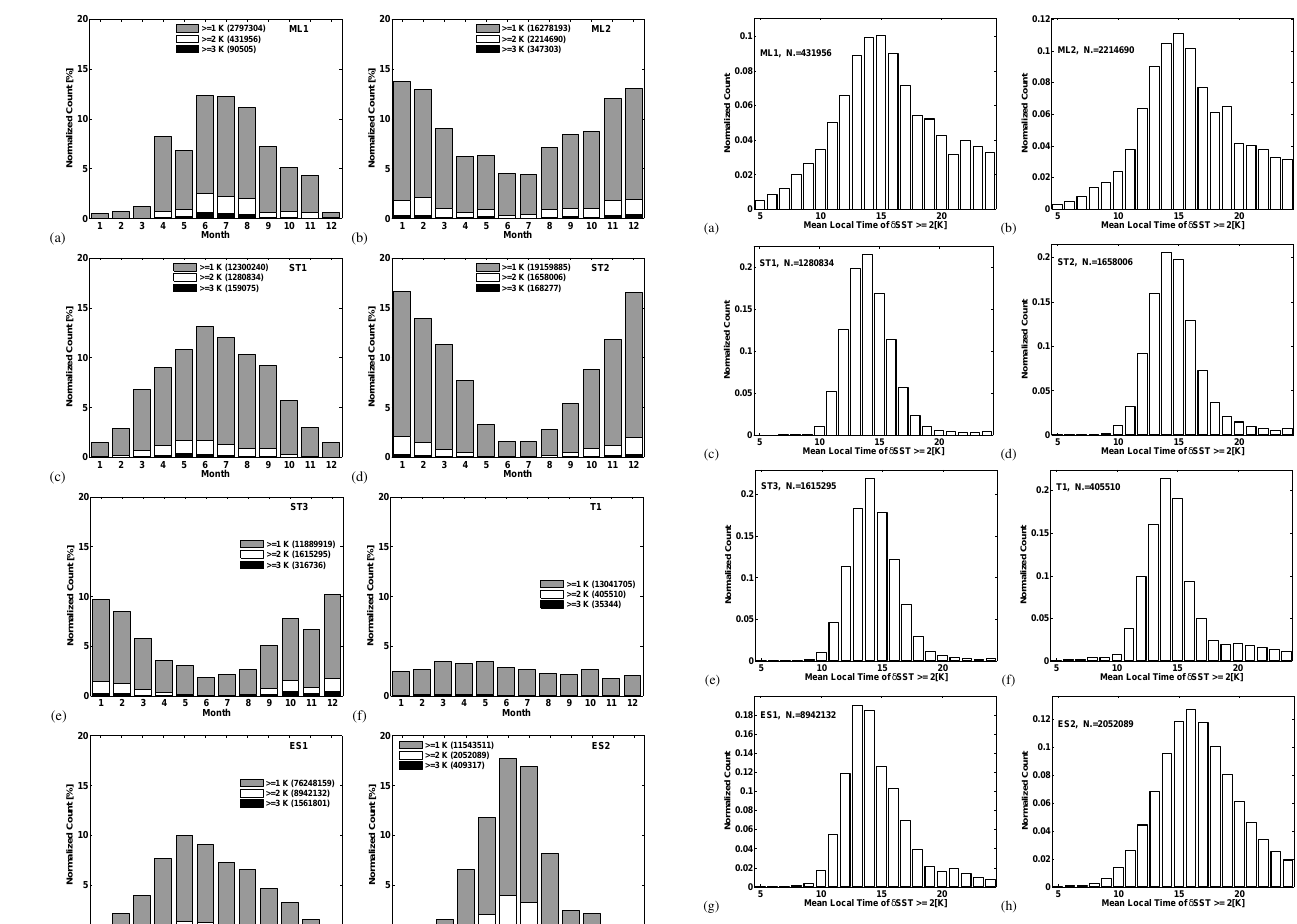
Fig. 7. Distribution of mean local time for δ SST ≥ 2K , in different domains of the SEVIRI disc: (a) ML1, (b) ML2, (c) ST1, (d) ST2, (e) ST3, (f) T1, (g) ES1and (h) ES2. Figure 7. Distribution of mean local time for δ SST ≥ 2K, in dif- ferent domains of the SEVIRI disc: (a) ML1, (b) ML2, (c) ST1, Fig.6. Monthlydistributionofhourly δ SSTexceeding1,2and3 K from2006–2011,normalisedoverthetotalnumberofquality5SSTper monthindomains: (a) ML1, (b) ML2, (c) ST1, (d) ST2, (e) ST3, (f) T1, (g) ES1and (h) ES2. Figure 6. Monthly distribution of hourly δ SST exceeding 1, 2 and (d) ST2, (e) ST3, (f) T1, (g) ES1 and (h) 3K from 2006–2011, normalised over the total number of quality 5 SST per month in domains: (a) ML1, (b) ML2, (c) ST1, (d) ST2, (e) ST3, (f) T1, (g) ES1 and (h) ES2.